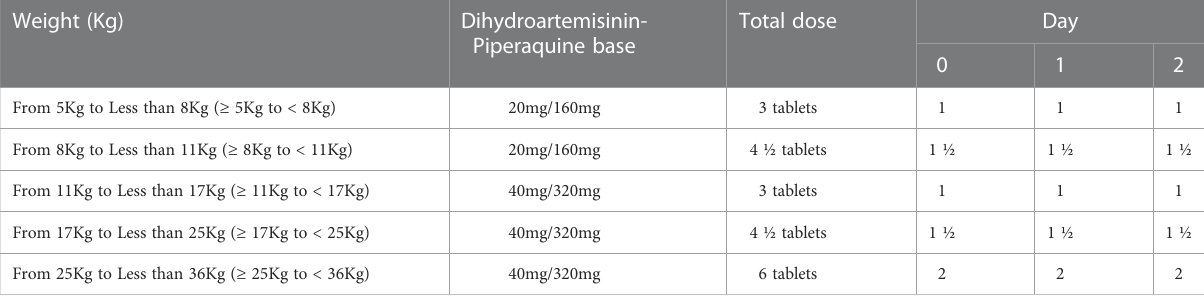
From 25Kg to Less than 36Kg ( ≥ 25Kg to <